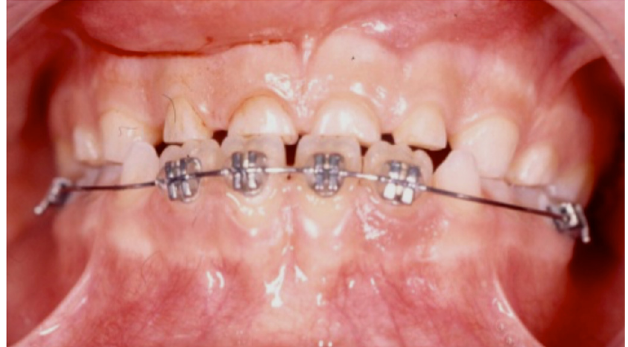
Fig. 2. Clinical view of patient A at the beginning of his treatment (age: 12 years).